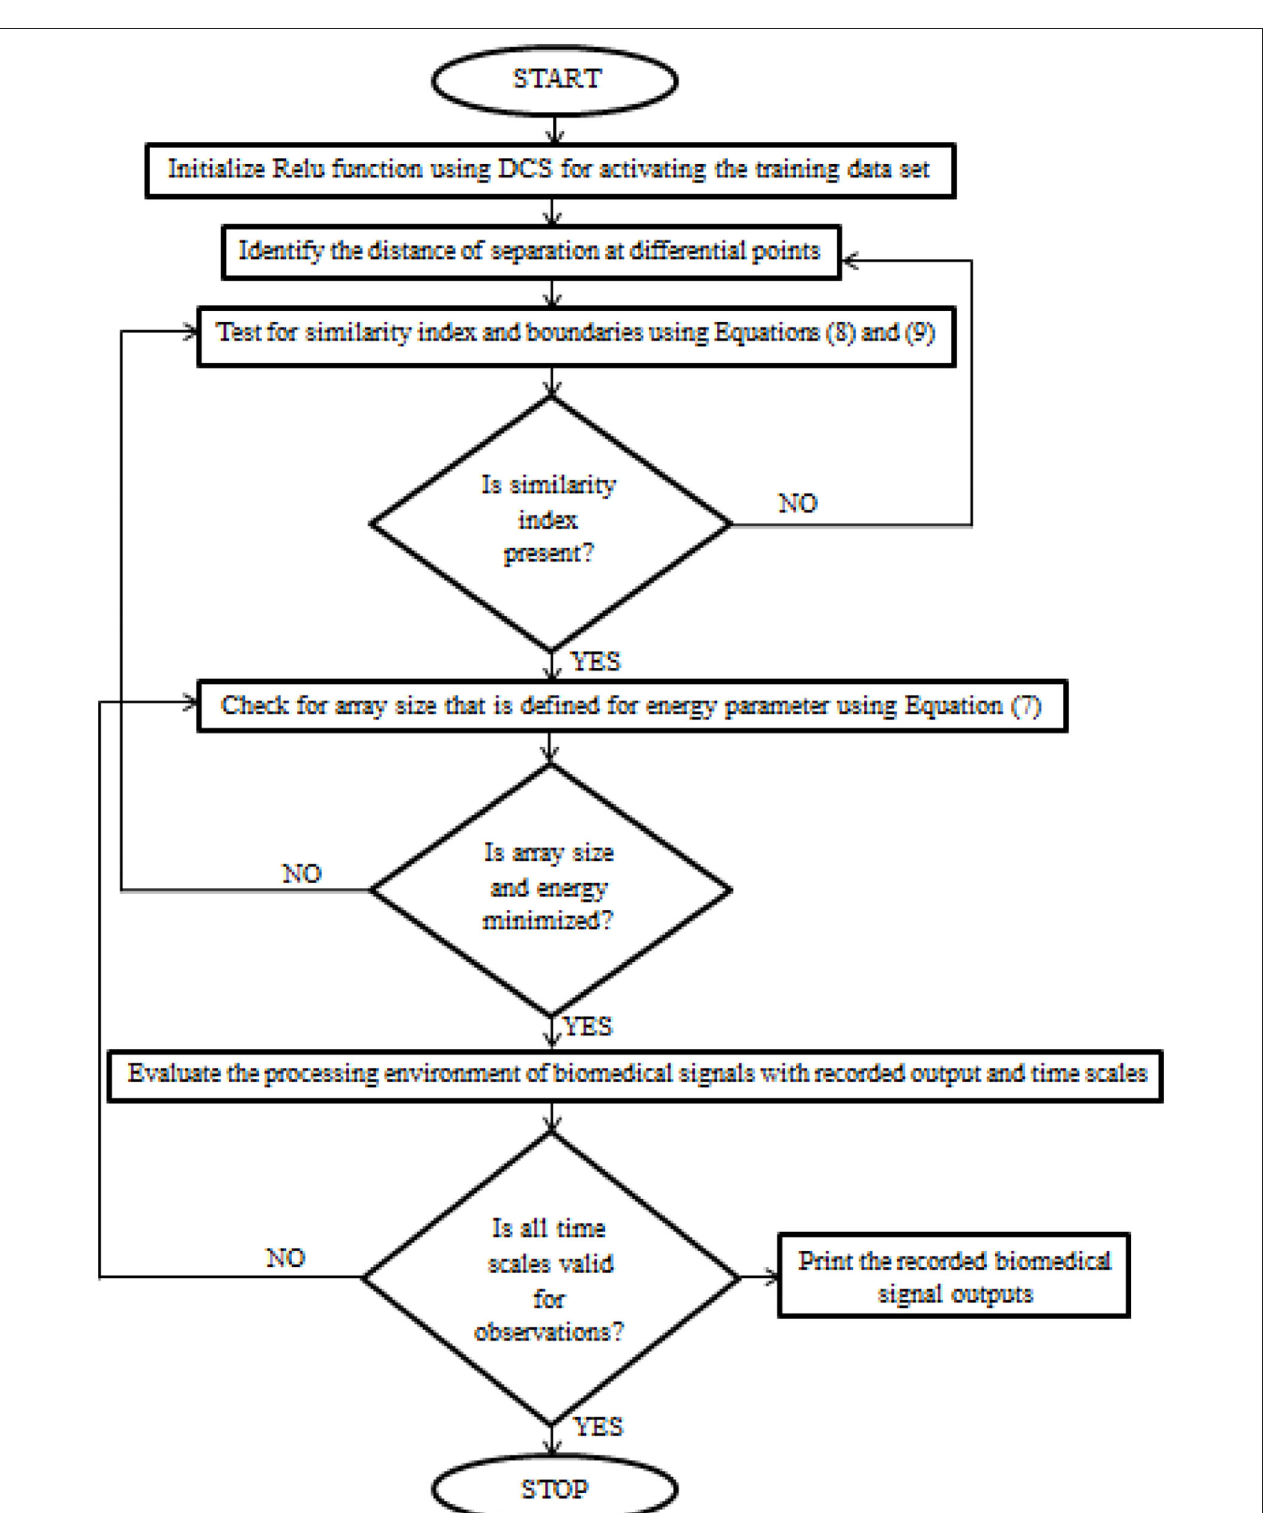
FIGURE 1 | The implementation procedure of Deep Conviction Systems (DCS) for realizing biomedical signals.